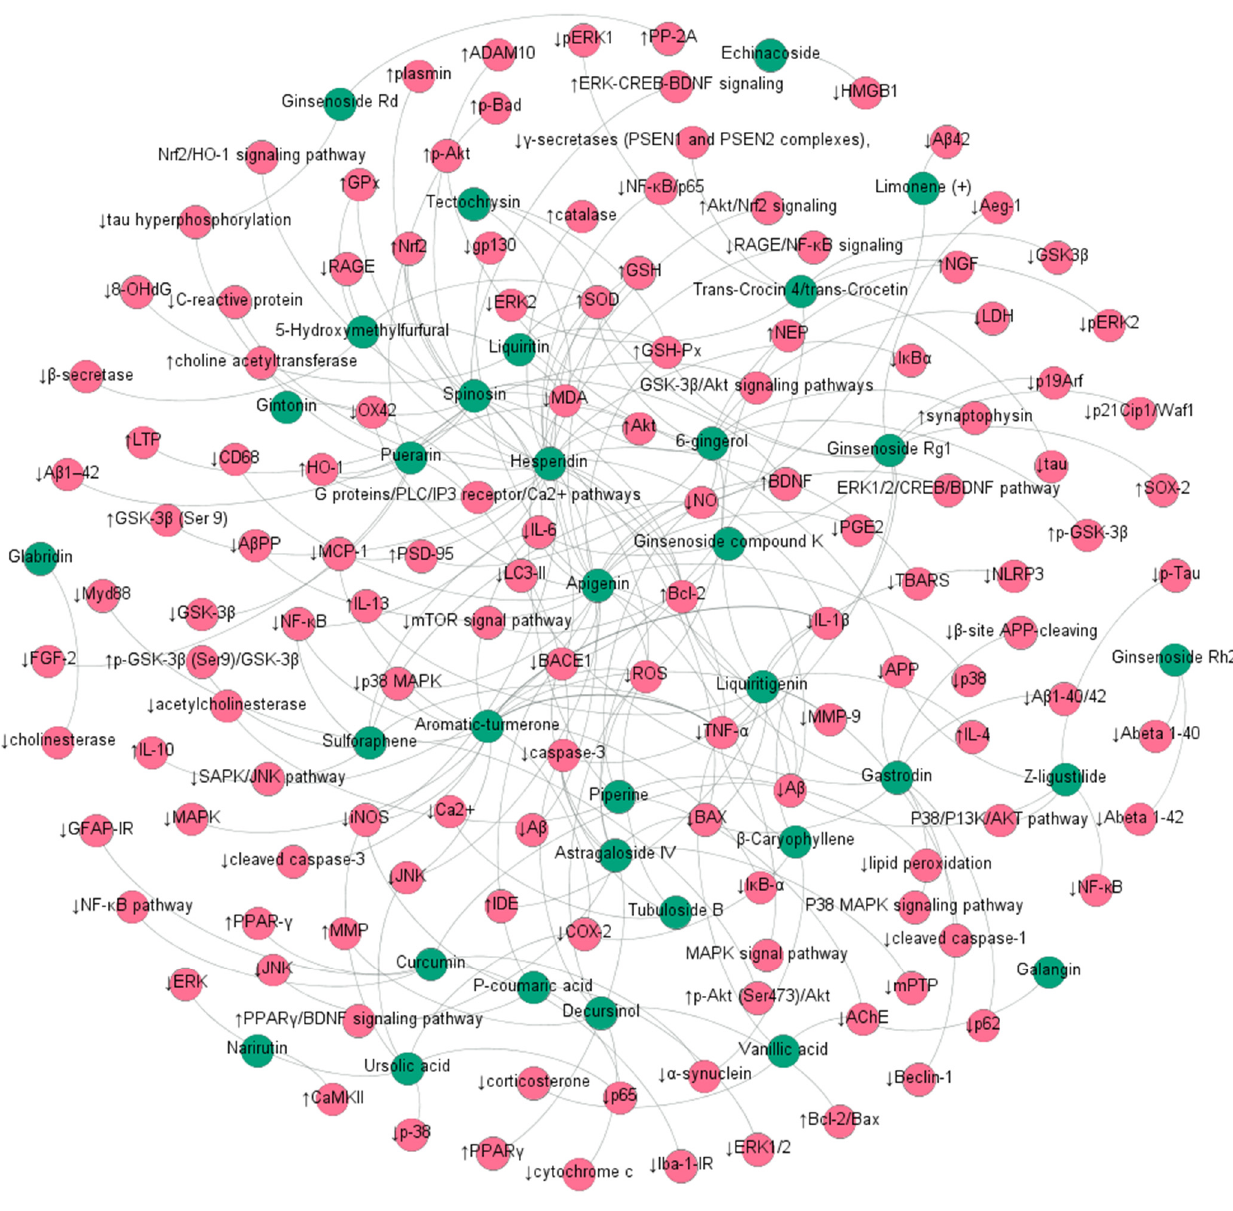
Figure 2. The ingredients of MFH antiAD network mechanism diagram. (Blue nodes represent ingredient, and red nodes represent targets/pathways) .